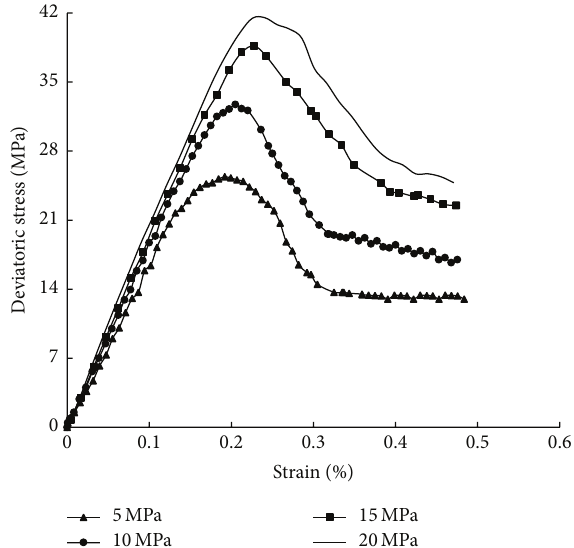
Figure 6: Stress-strain curves of biaxial compression tests.